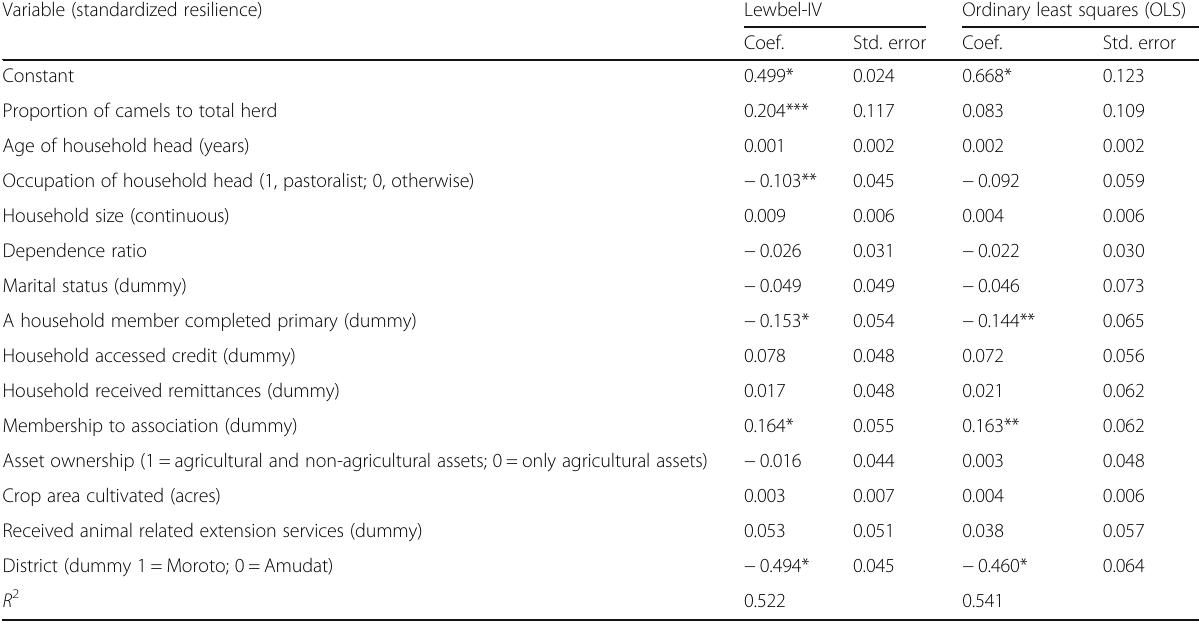
Table 6 OLS and Lewbel-IV estimates of the factors influencing household ’ s resilience to droughts Variable (standardized